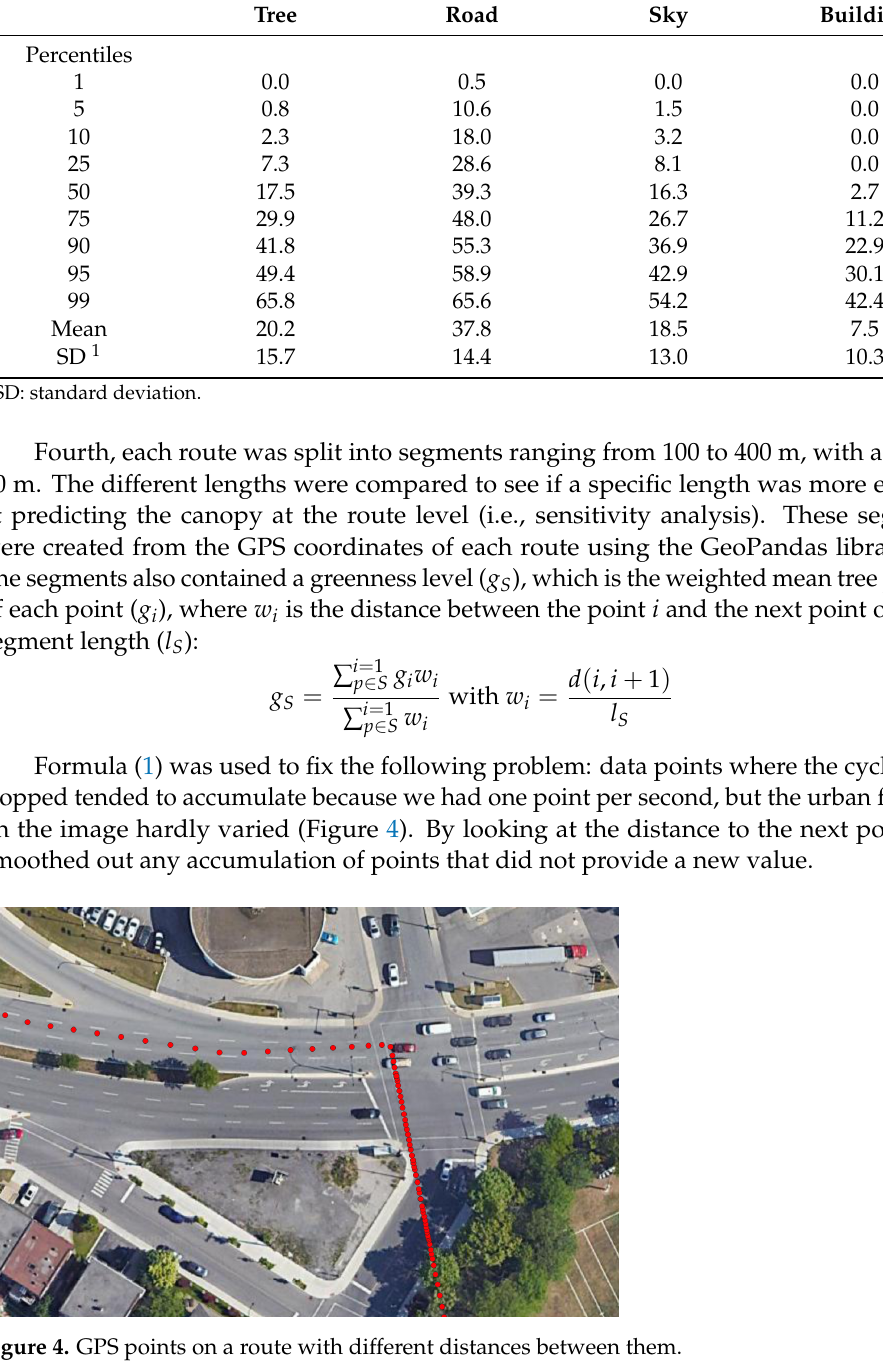
Table 2. Univariate statistics for the four detected categories in the images (n = 311,446). Tree Road